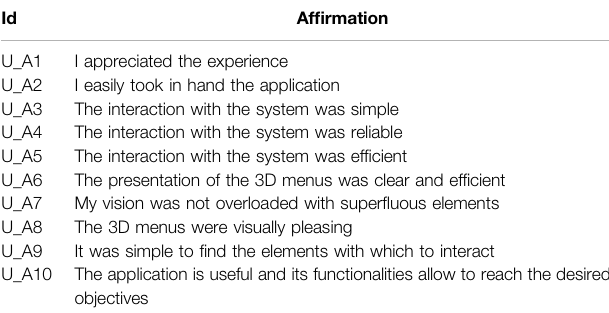
TABLE 1 | The ten statements we used to measure the usability and user experience of our smart-home